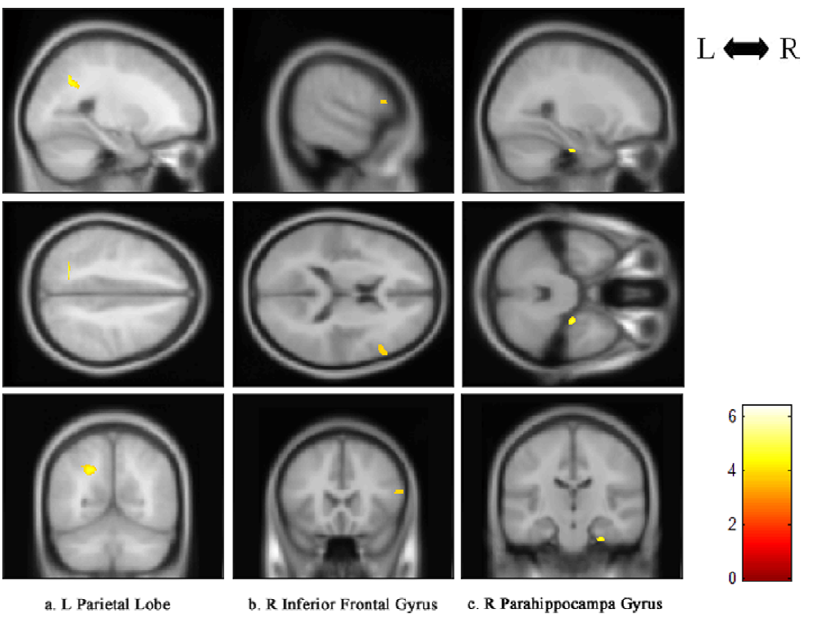
Figure 2. Regional cortical thinning in recent onset PTSD patients versus trauma survivors without PTSD. Regional cortical thinning in the following areas were rendered onto orthogonal slices: (a) left parietal lobe; (b) right inferior frontal gyrus; (c) right parahippocampal gyrus. L, left hemisphere; R, right hemisphere. PTSD, post-traumatic stress disorder.